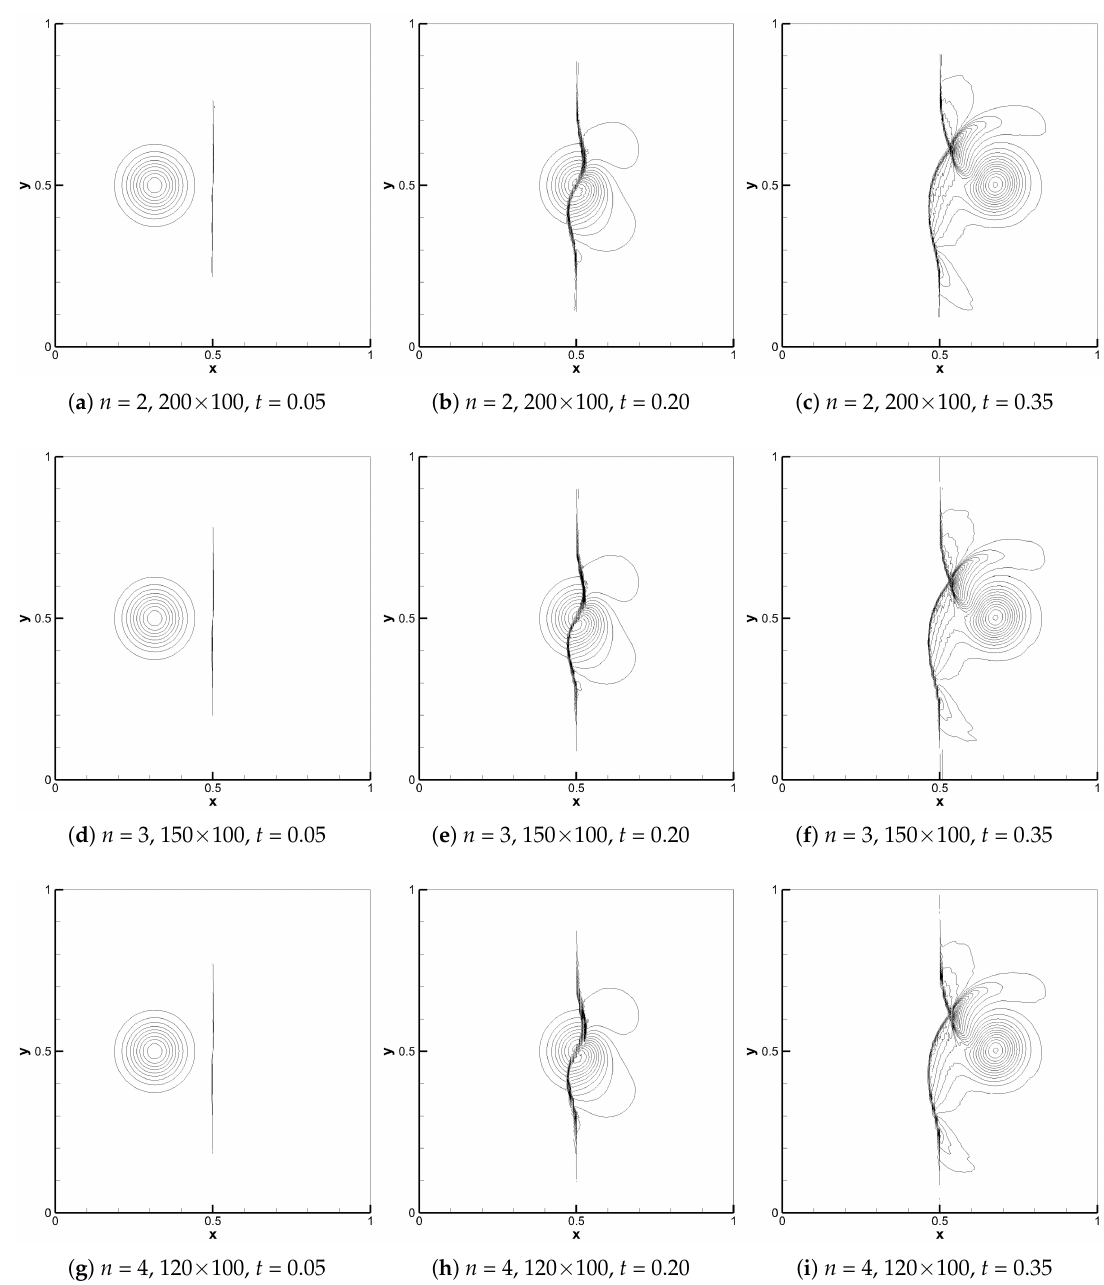
Figure 8. Two-dimensional shock-vortex interaction problem at various times. Forty-one pressure contours are used from 0.84 to